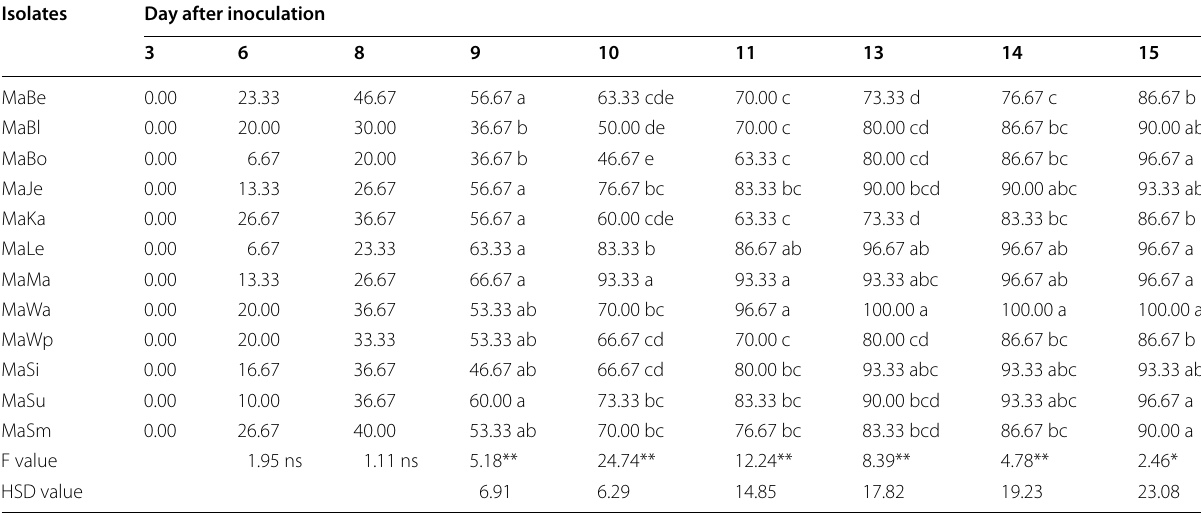
Different lowercase letters denote significant differences (ANOVA, Tukey’s test, P ns, not significantly different *significantly different ( P